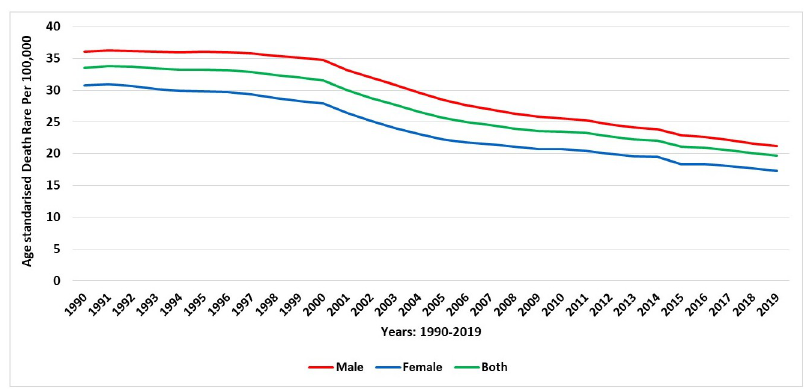
Fig 7. Trends in the age-standardised death rate of COPD during 1990–2019 in Saudi Arabia, stratified by gender.